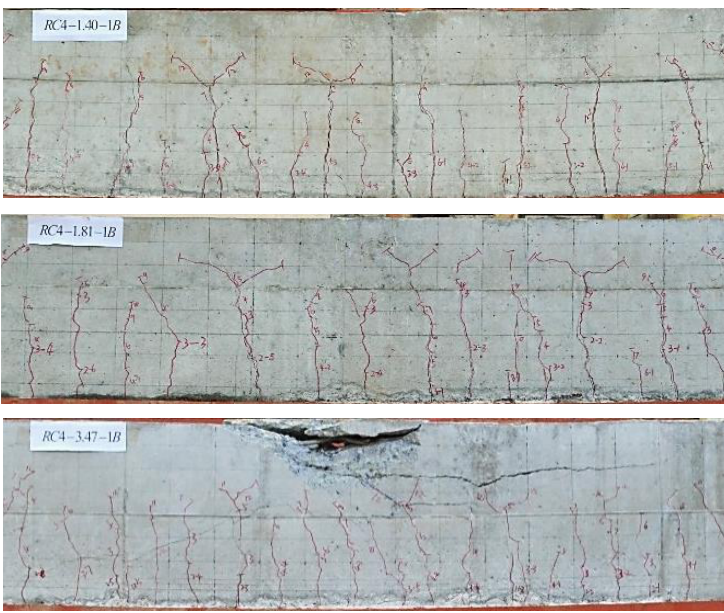
Figure 3. Cracks distribution on the pure bending part of test beams.